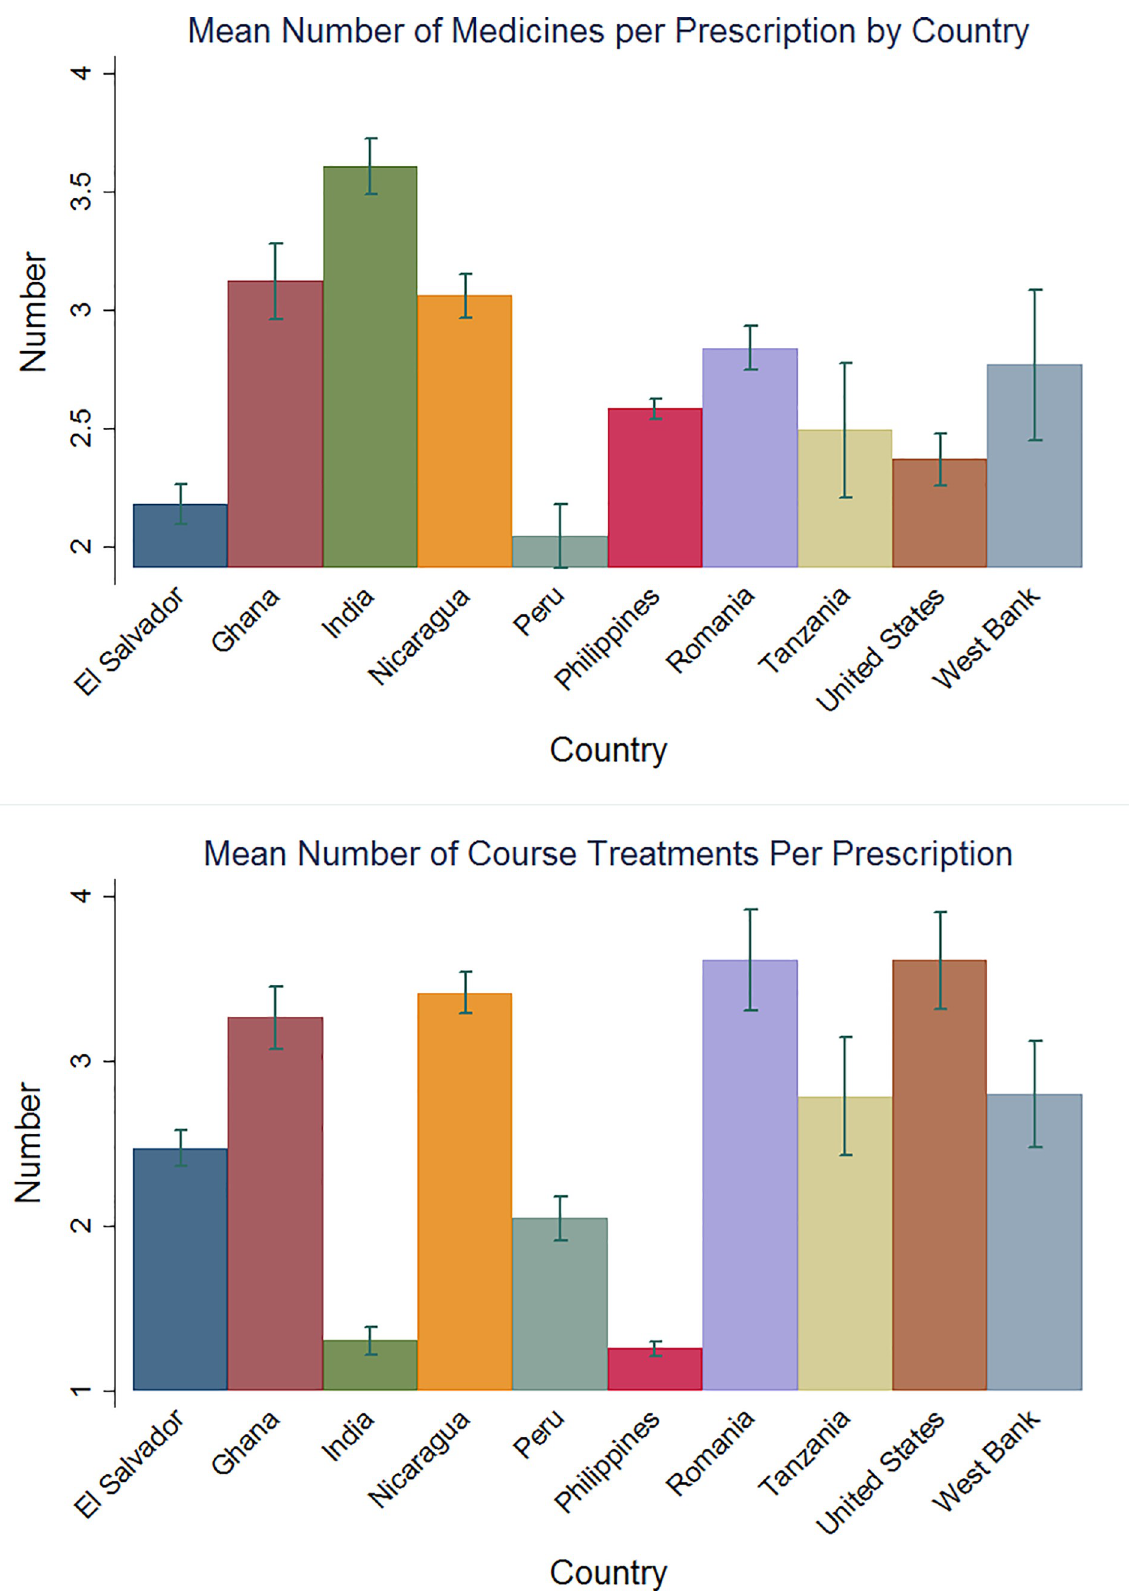
Fig 2. Estimated number medications and course treatments per prescription by country. https://doi.org/10.1371/journal.pone.0206790.g002 PLOS ONE | https://doi.org/10.1371/journal.pone.0206790 November2,